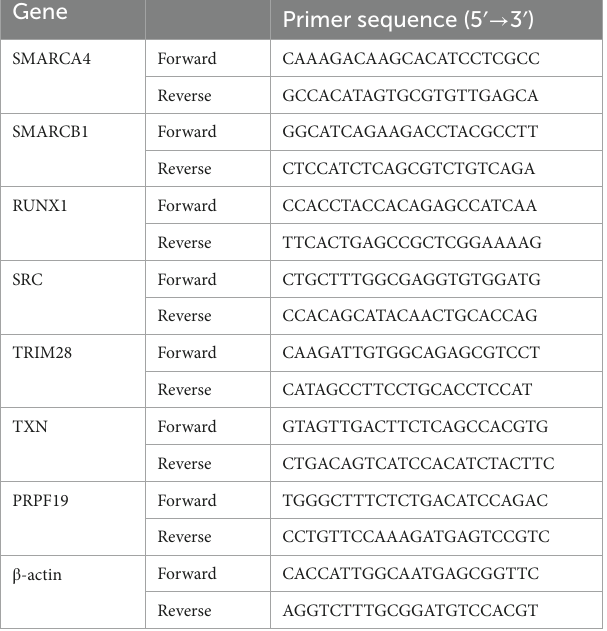
TABLE 1 Primer sequences for